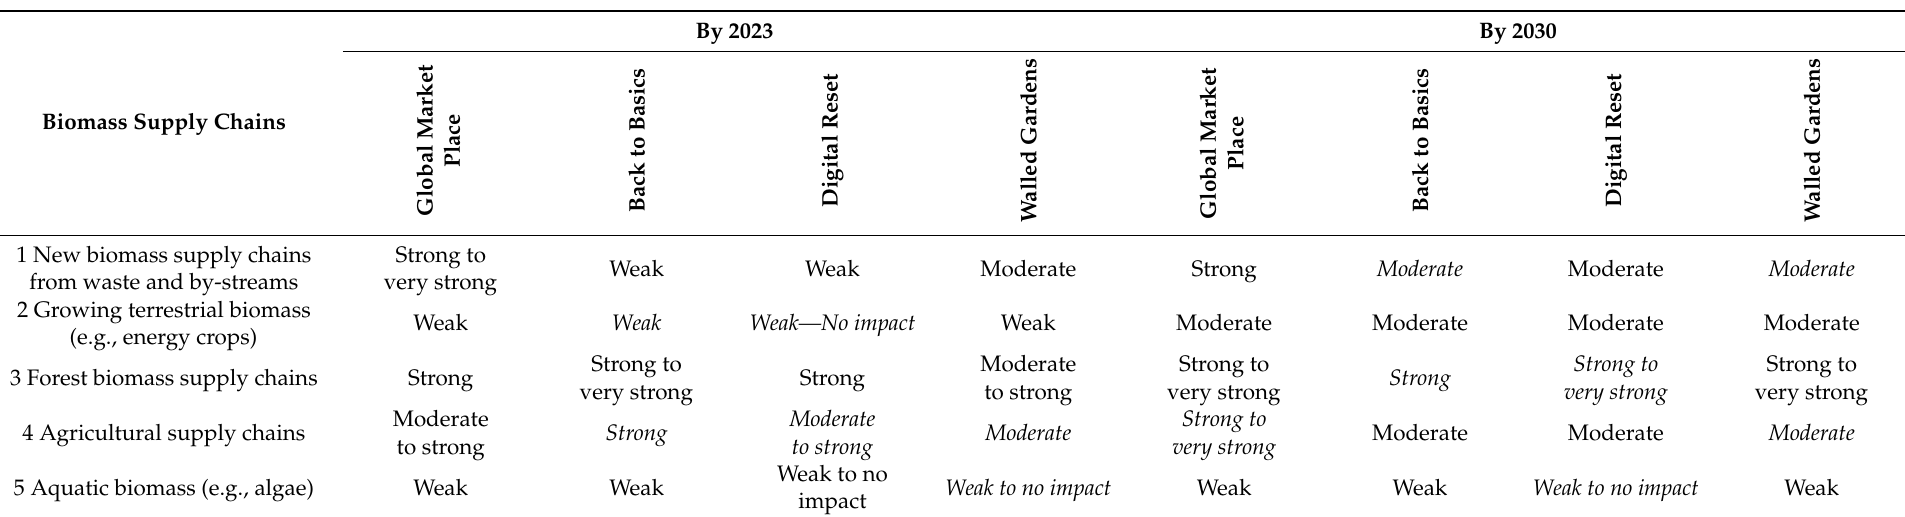
Table A6. Expert consensus on impact of investments in different biomass supply chains on economic growth